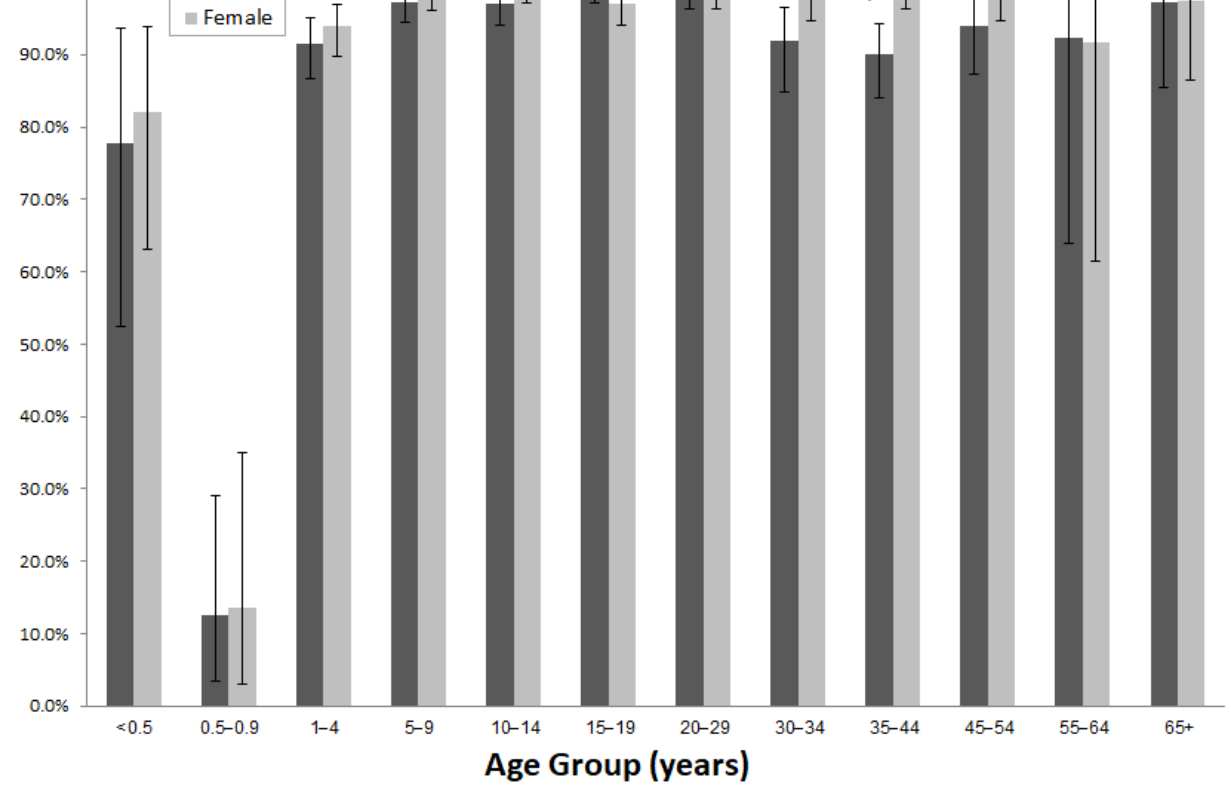
Figure 1. Sero-positivity for rubella by age group and gender. * p -value < 0.05. Sero-positivity rates for rubella were significantly higher in females than males in the 30–34 and 35–44 age groups. Univariable and multivariable analyses for sero-negativity for rubella IgG by demo- graphic characteristics are presented in Table Table 4. The association between demographic characteristics and sero-negativity for rubella in Is- rael, 2015, univariable and multivariable analyses.